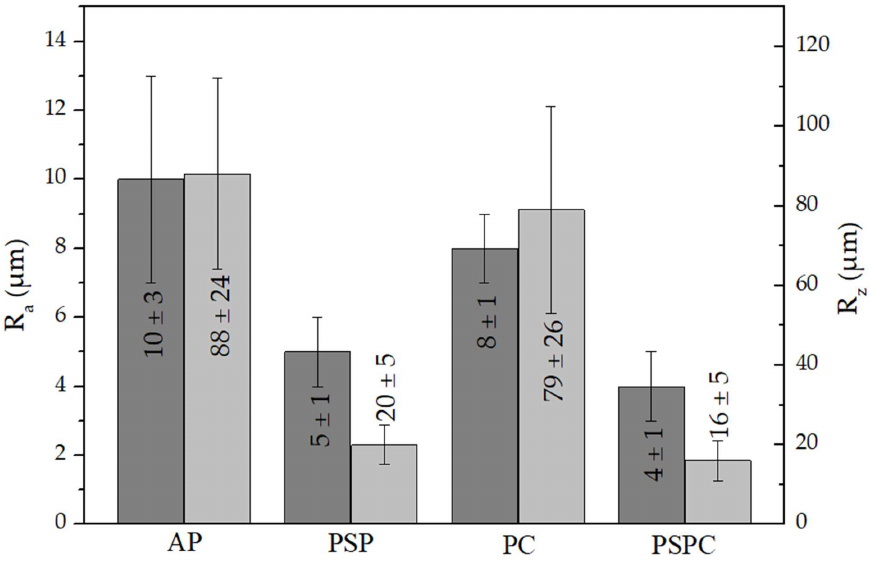
Figure 7. R a and R z roughness values for as-printed, printed and shot peened, printed and coated and printed, shot peened and coated 316L